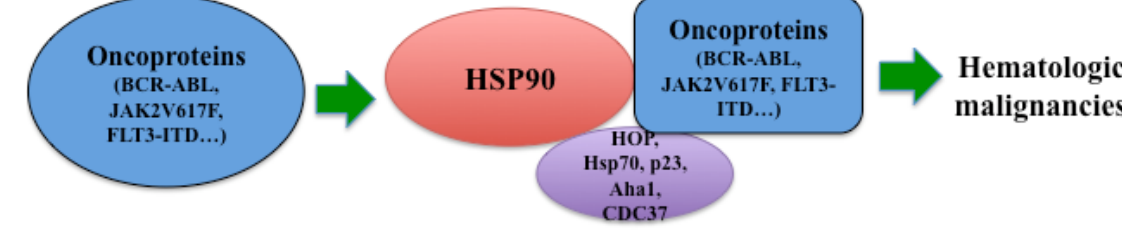
Figure 1. Role of Hsp90 in hematological malignancies. Hsp90 stabilizes oncogenic kinases including BCR-ABL, JAK2V617F and FLT3-ITD, etc . Co-chaperones, such